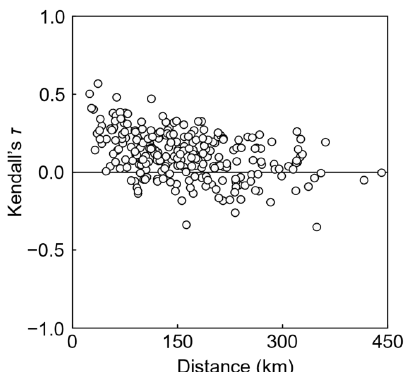
Figure 2. Kendall’s τ of annual maximum daily rainfall between stations plotted against distance.